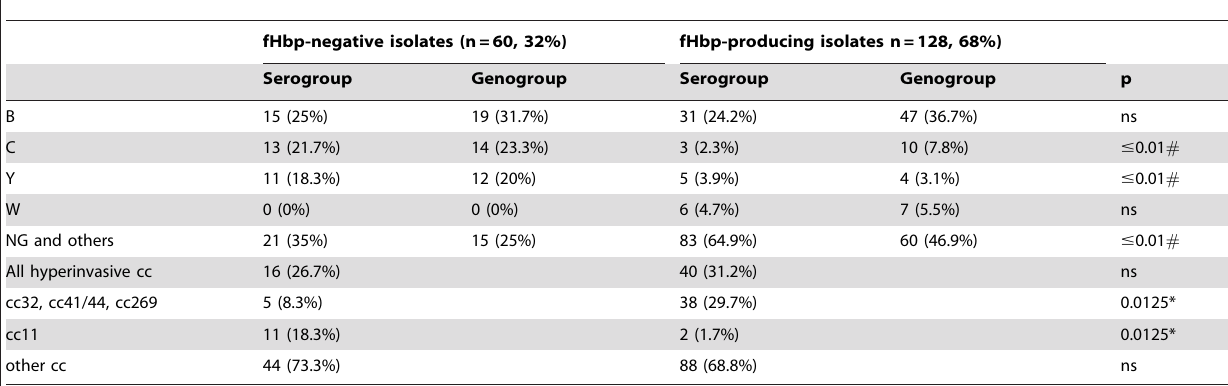
Table 2. Distribution of groups and clonal complexes (numbers and percentages) of carriage isolates according to their levels of production of